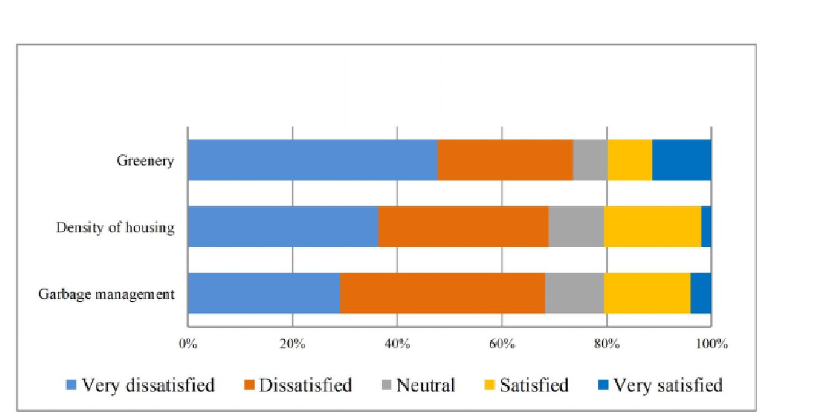
Fig 3. Satisfaction with neighbourhood environment. Source: Authors’ compilation, 2019.